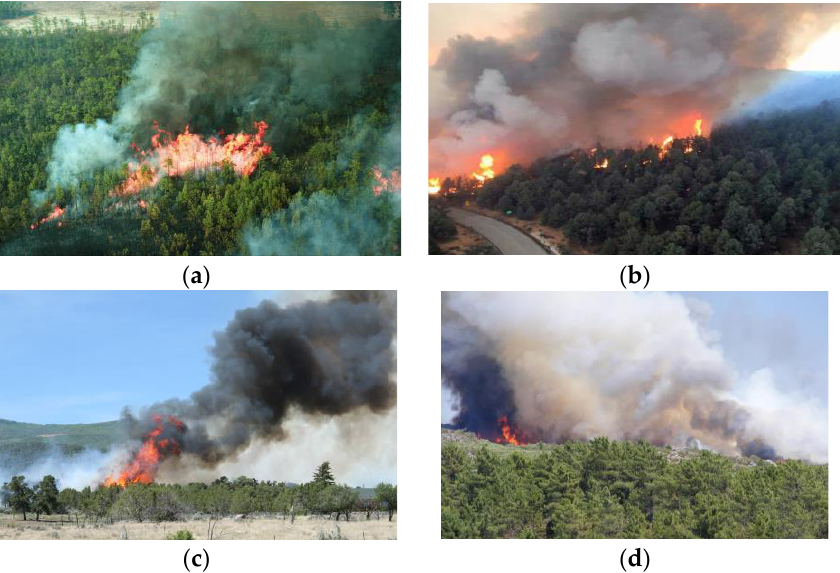
Figure 1. Forest fire smoke in a complex context. ( a , b ) indicates that the fire is spreading, and smoke is present; ( c , d ) indicates that the fire is small, and smoke is present.